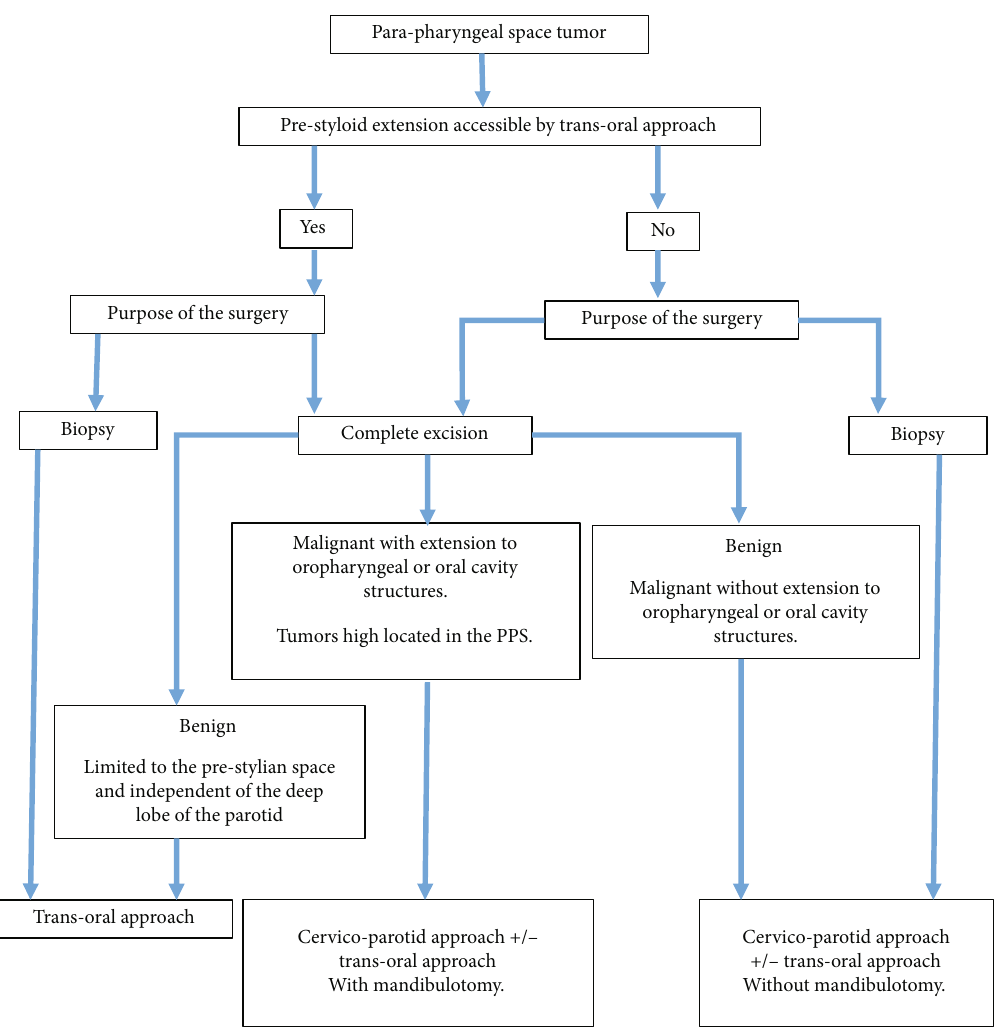
Figure 2: Strategy of choice of the surgical approach in parapharyngeal space